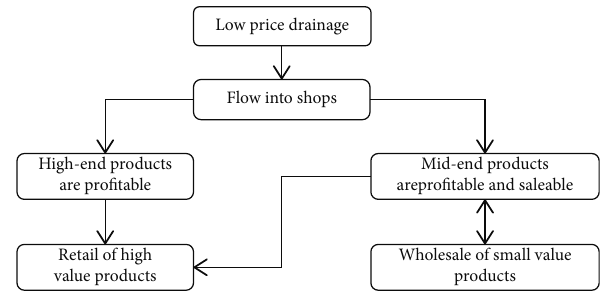
Figure 4: Product model positioning.